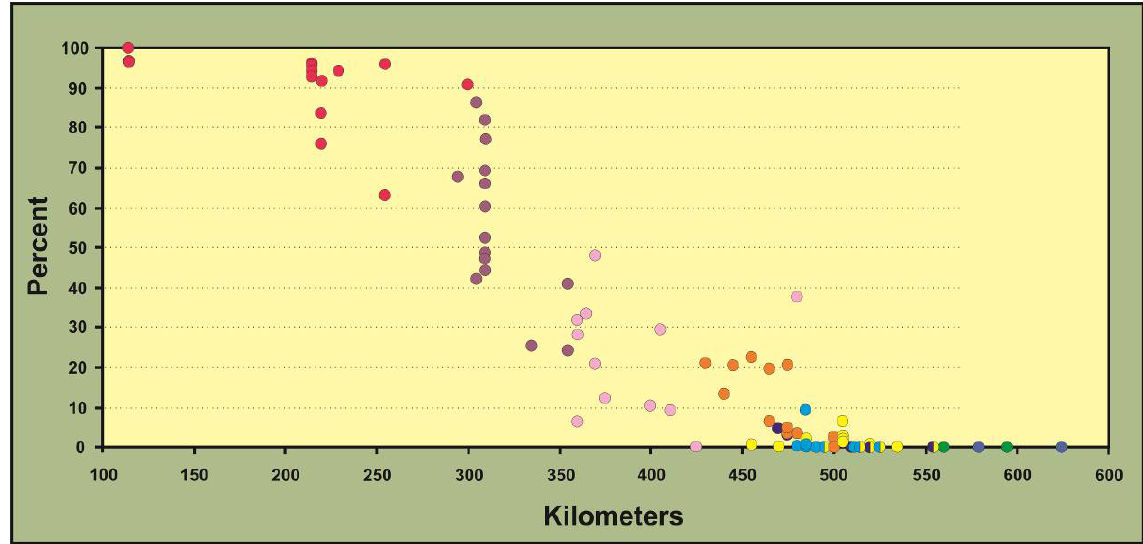
Figure 4. Correlation between frequency of lithic raw materials and distances to the Tandilia